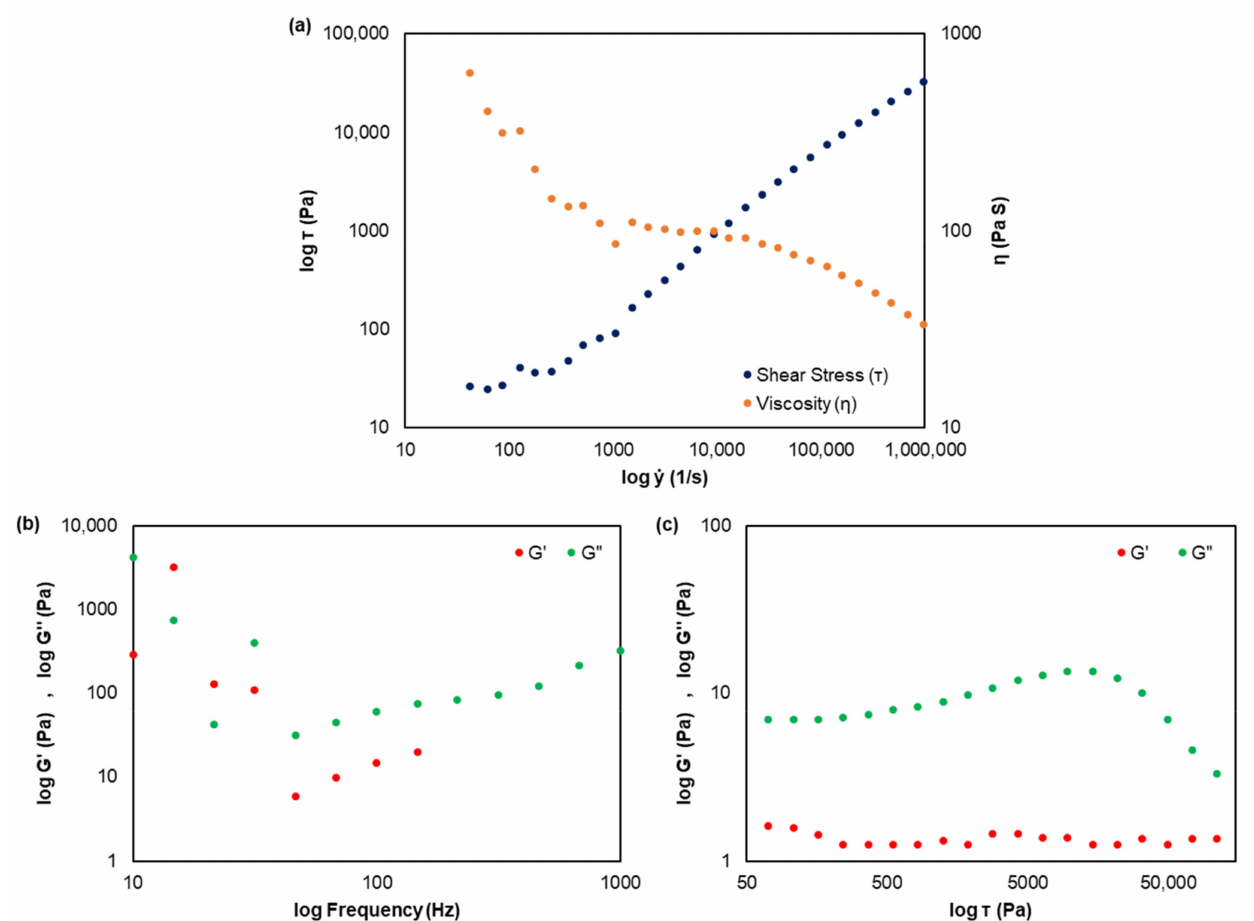
Figure 5. Rheological analysis of CMC/EO (5 mg/mL) at 23 ± 1 ◦ C: shear stress and viscosity as a function of shear rate ( a ); storage and loss modulus as a function of frequency ( b ); and storage and loss modulus as a function of shear stress ( c ).